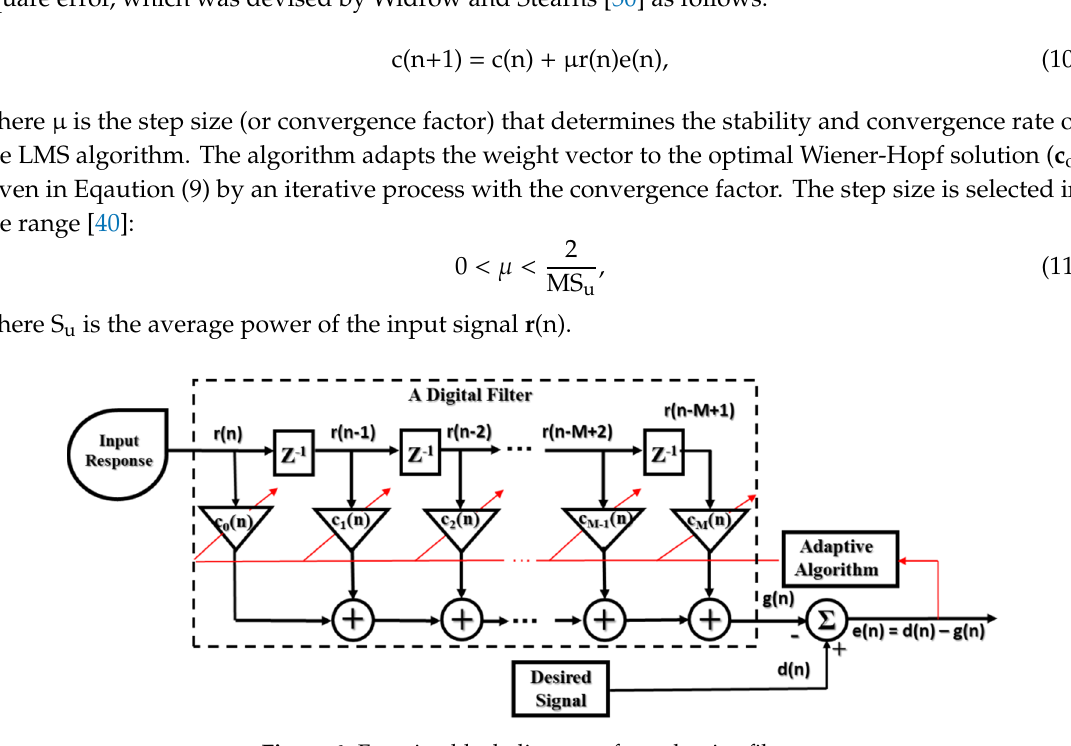
Figure 6. Function block diagram of an adaptive filter.